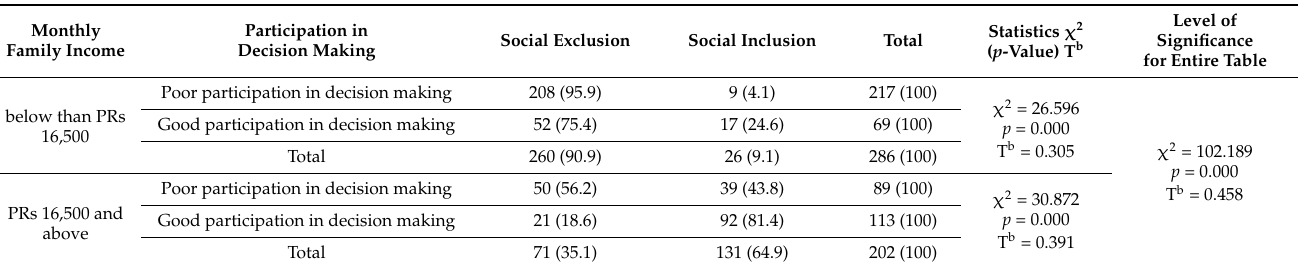
Table 4. Social inclusion of PWDs and participation in decision making while controlling monthly family income.